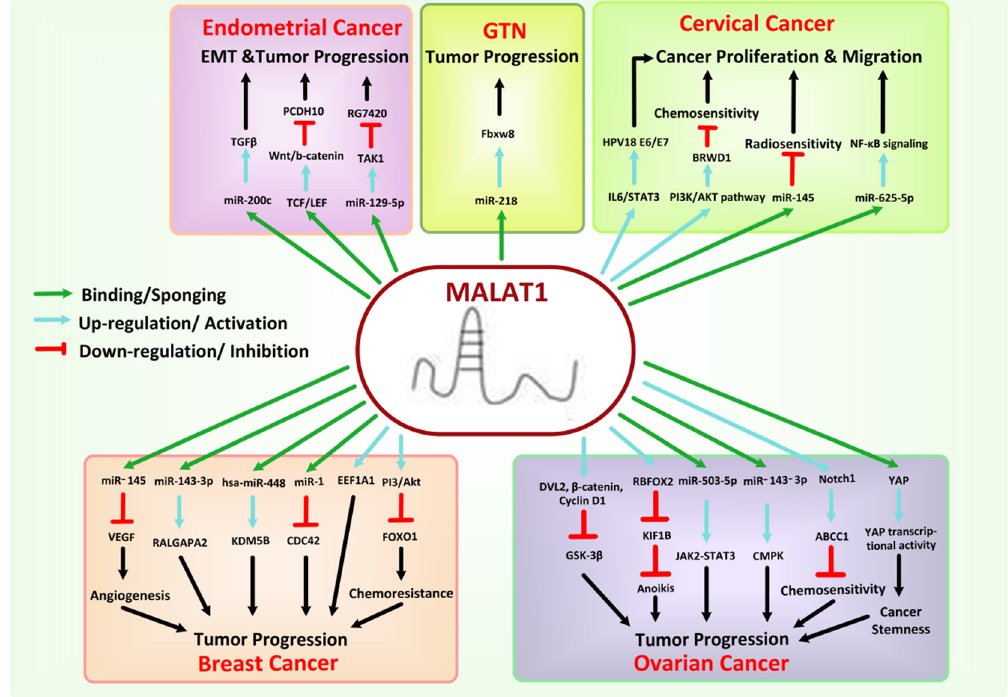
Figure 7. Mechanism associated with the oncogenic role of MALAT1 in female-oriented cancers.